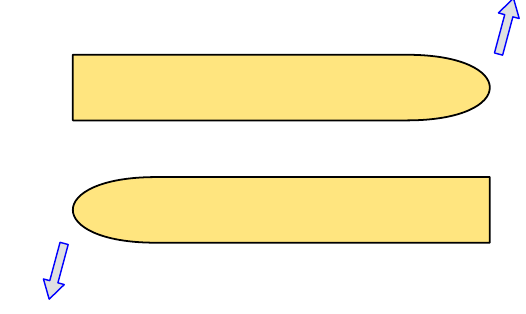
Fig. 3. Pressure distribution of the ships following opposite directions and turning tendencies for ships